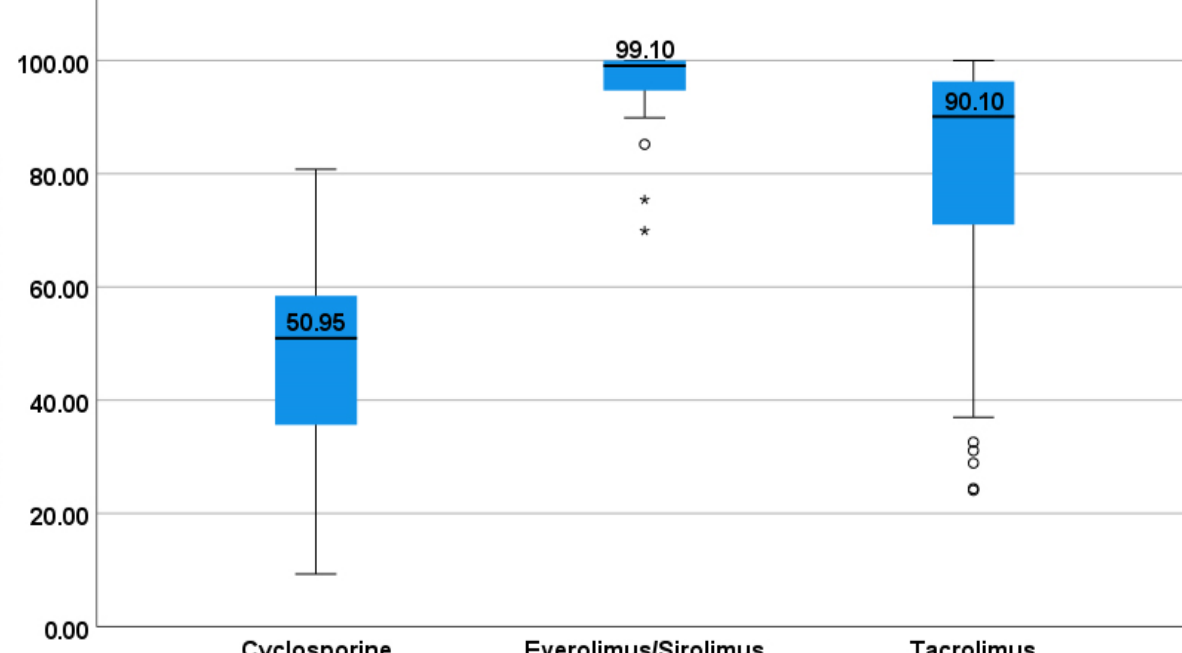
Figure 2. Comparison of time spent in the therapeutic